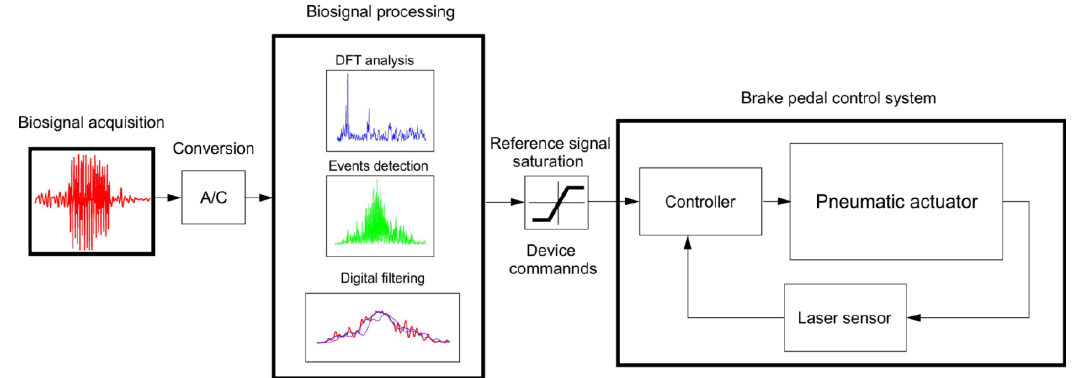
Figure 10. Block diagram of the bioelectric signal processing (BSP).